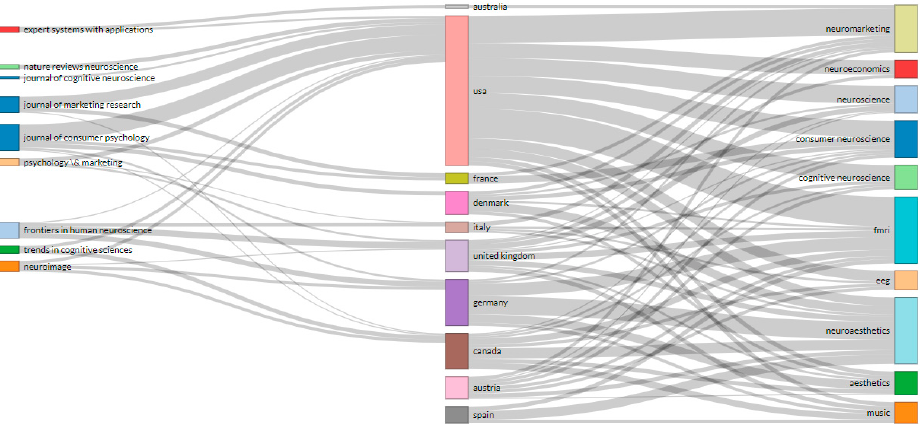
Figure 7. Three-Fields Plot. Middle Field (Countries): Number of items (1–10), Left Field (Sources): Number of items (1–10) and Right Field (Keywords): Number of items (1–10). Max width possible (1–50).